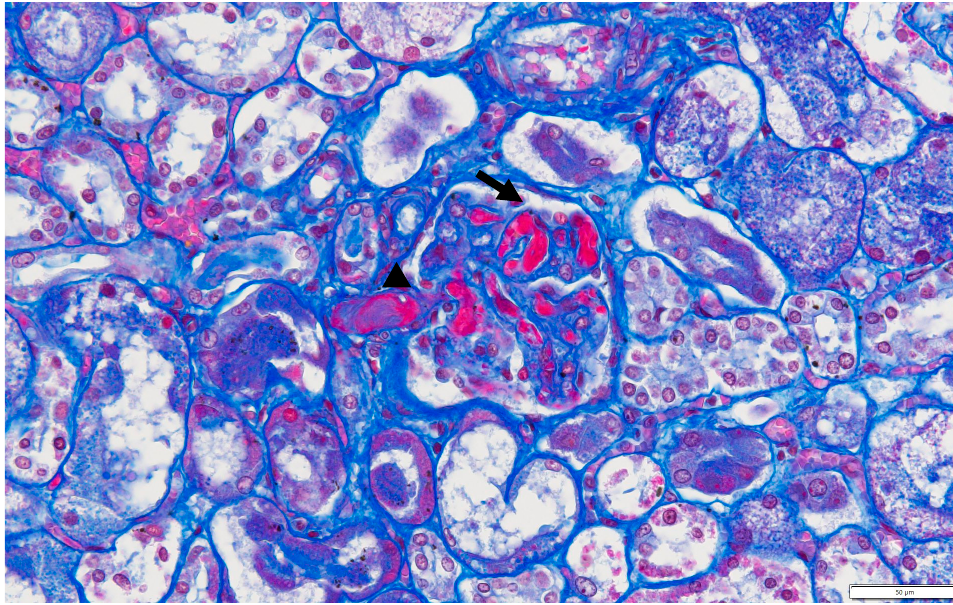
Figure 2. Glomerular fibrin thrombi with entrapped red blood cells can be seen (arrow). Fibrin thrombi can also be seen in the arteriole (arrowhead). (Masson trichrome ×40).